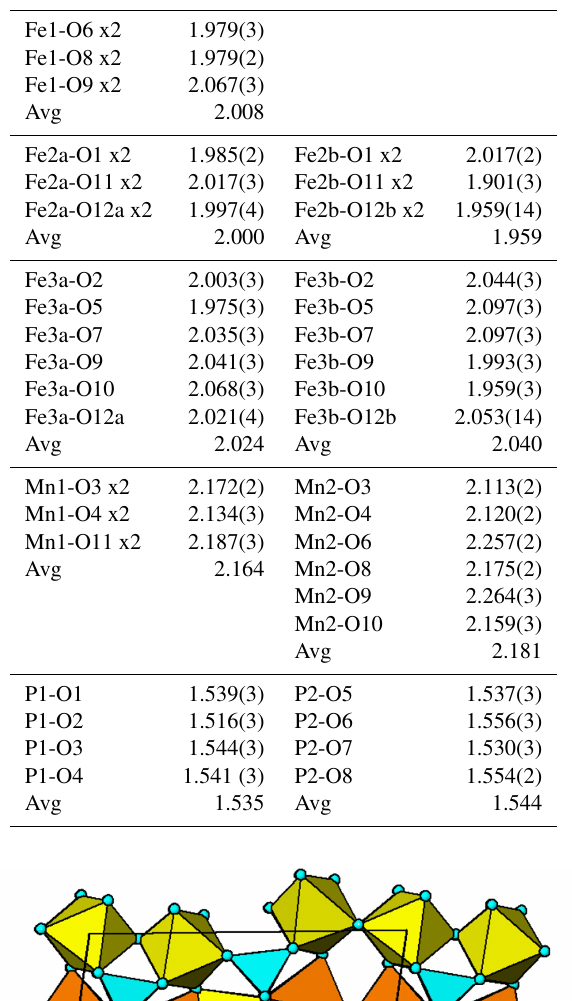
Table 4. Polyhedral bond lengths (Å) for kenngottite.